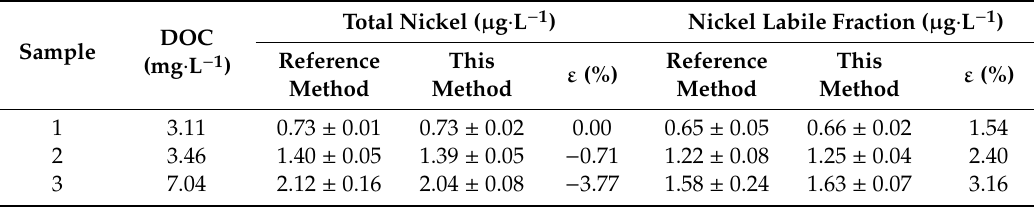
Table 3. Total and labile nickel concentrations in natural water samples.